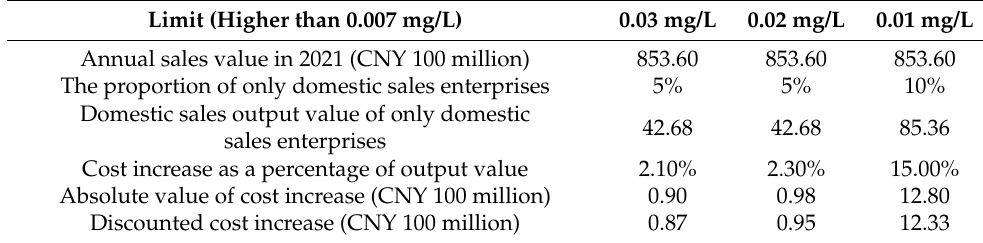
Table 6. Patent use and R&D expenses due to the limit change.